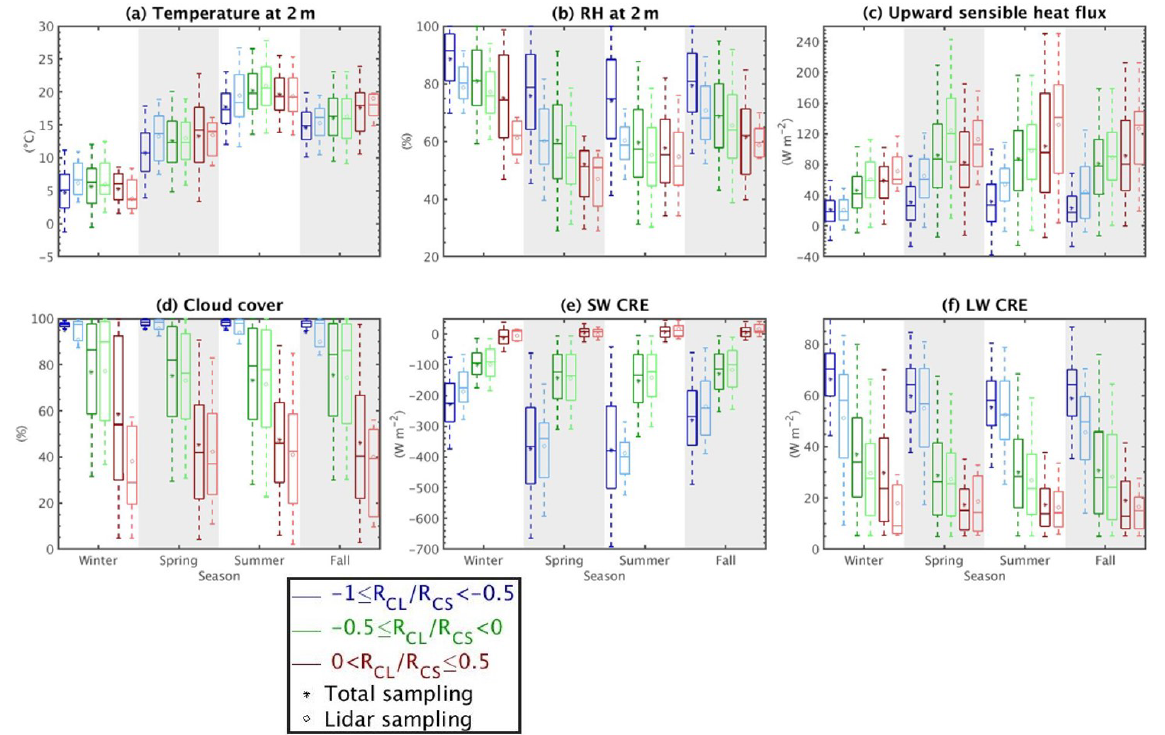
Figure 9. Daytime values for (a) temperature, (b) relative humidity, (c) upward sensible heat flux at 2m, (d) cloud cover retrieved from a sky imager, and (e) shortwave and (f) longwave cloud radiative effect. Colors and boxplots follow the same definition as in Fig. 8a.